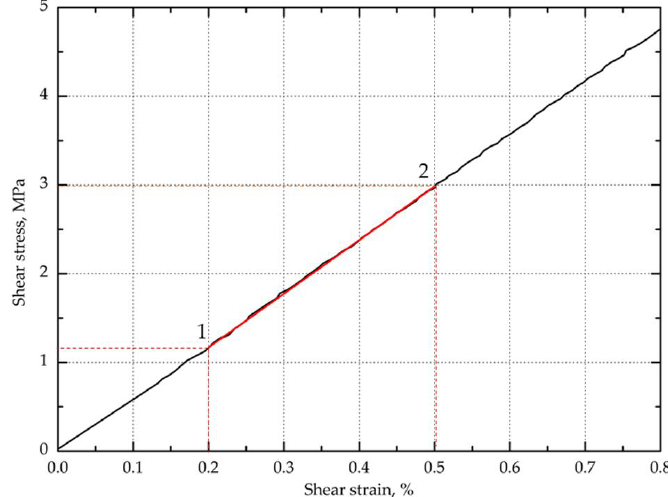
Figure 11. Representative shear stress-strain curve at the proportional limit.